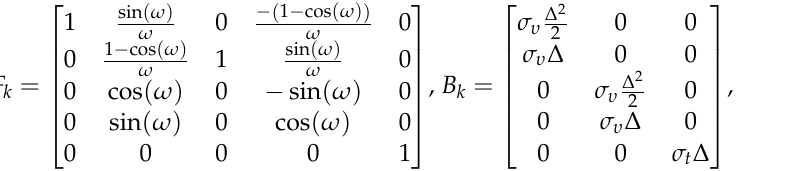
Formatted: Font: Palatino Linotype